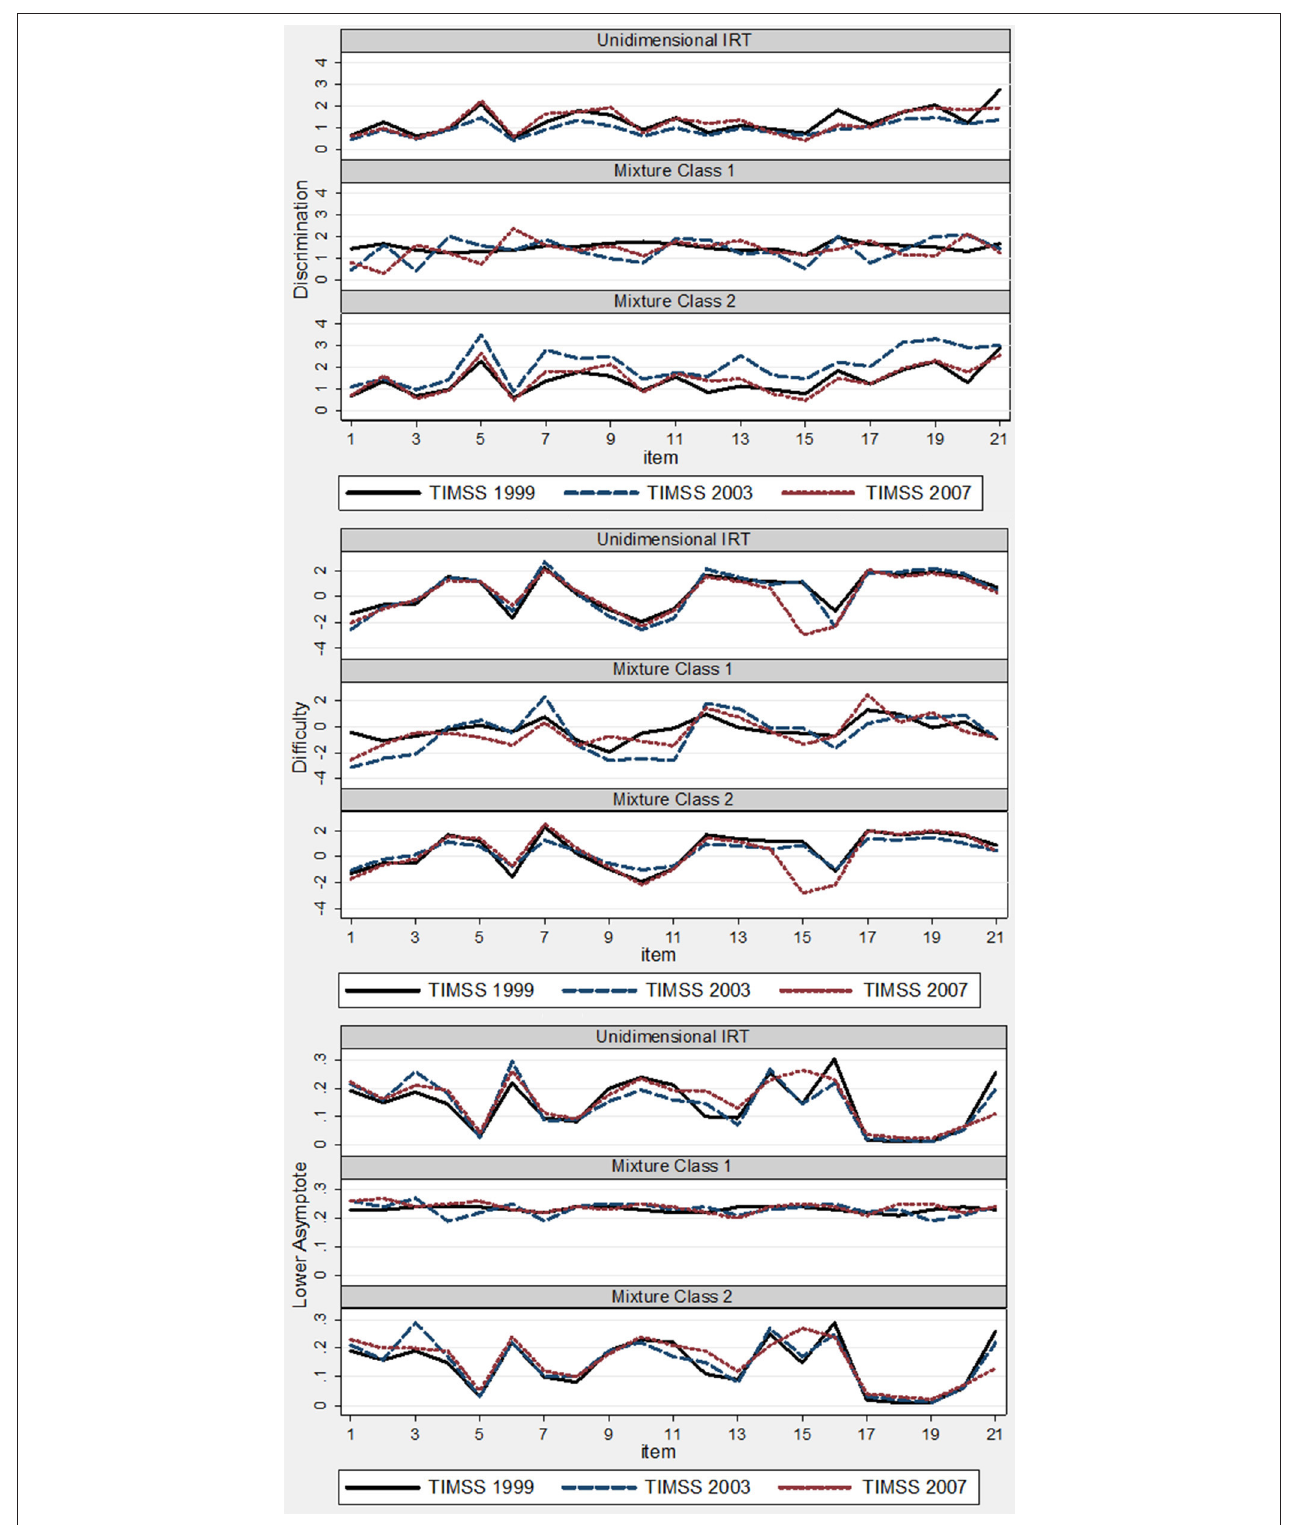
FIGURE 1 | Plots of item parameters by measurement model: TIMSS 1999, 2003, and 2007.